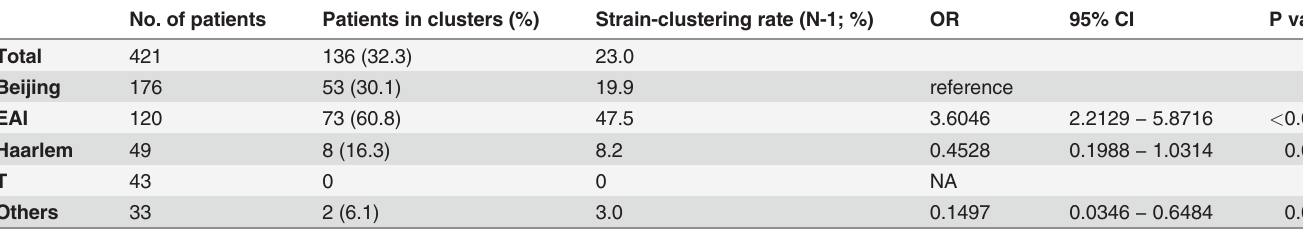
Table 2. Univariate analysis of cluster rates in different MTB lineages. No. of patients